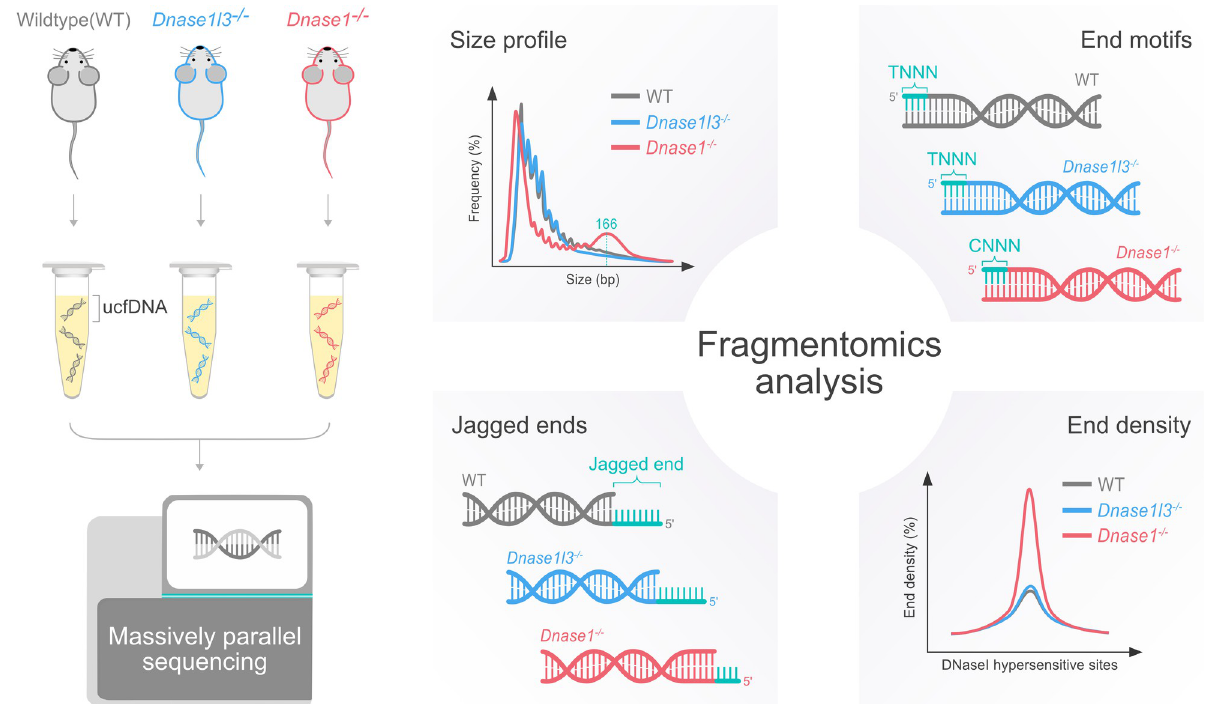
Fig 1. Overview of the study design. Urinary cfDNA was isolated from the urine samples of WT, Dnase1l3 -/- and Dnase1 -/- mice and subjected to massively parallel sequencing. Analyses of ucfDNA fragmentation, including the sizes, end motifs, jagged ends and end density across the regions within the DHSs, were